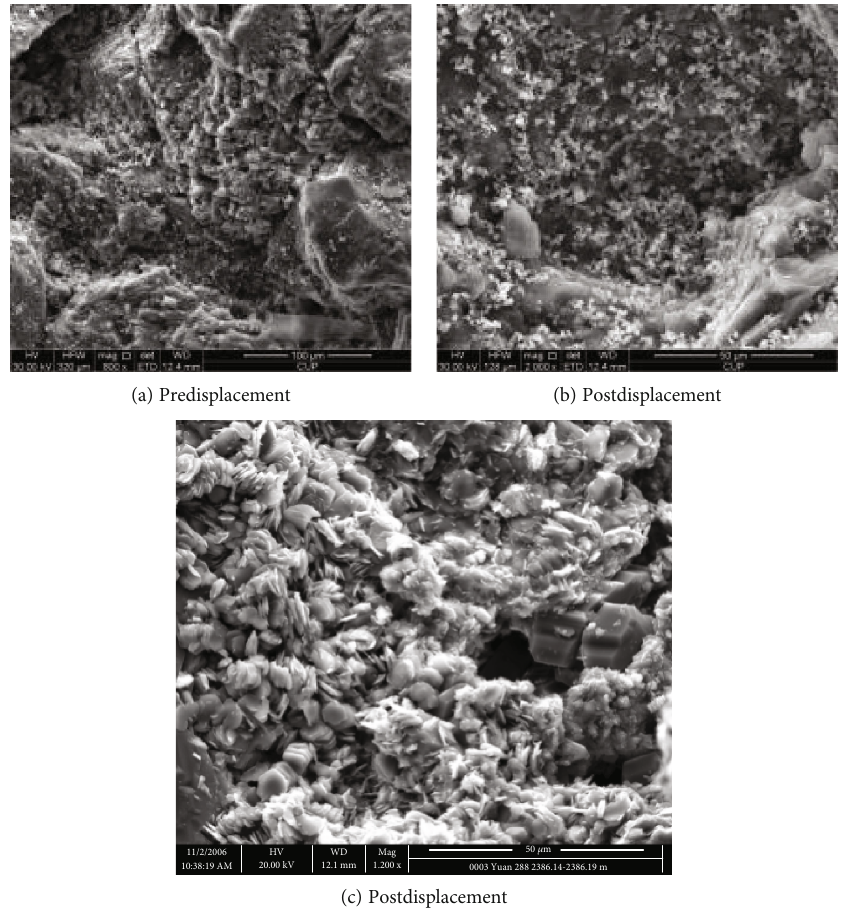
Figure 15: SEM pictures of rocks before and after interactions with CO